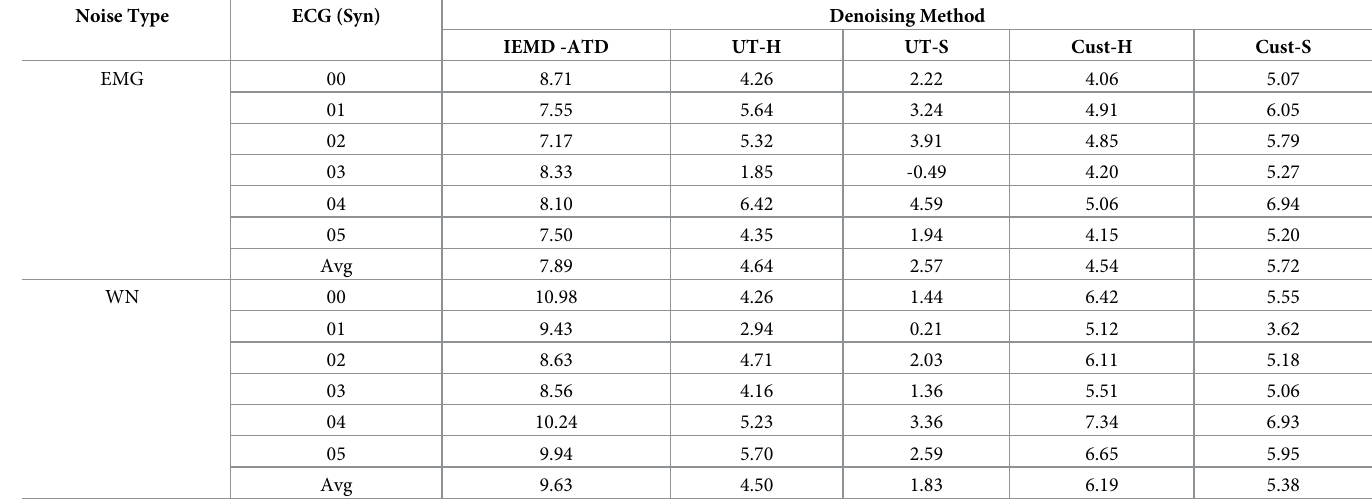
Table 5. SNR improvement of 5 denoising methods for synthetic ECGs contaminated with EMG and WN at 5 dB. Noise Type